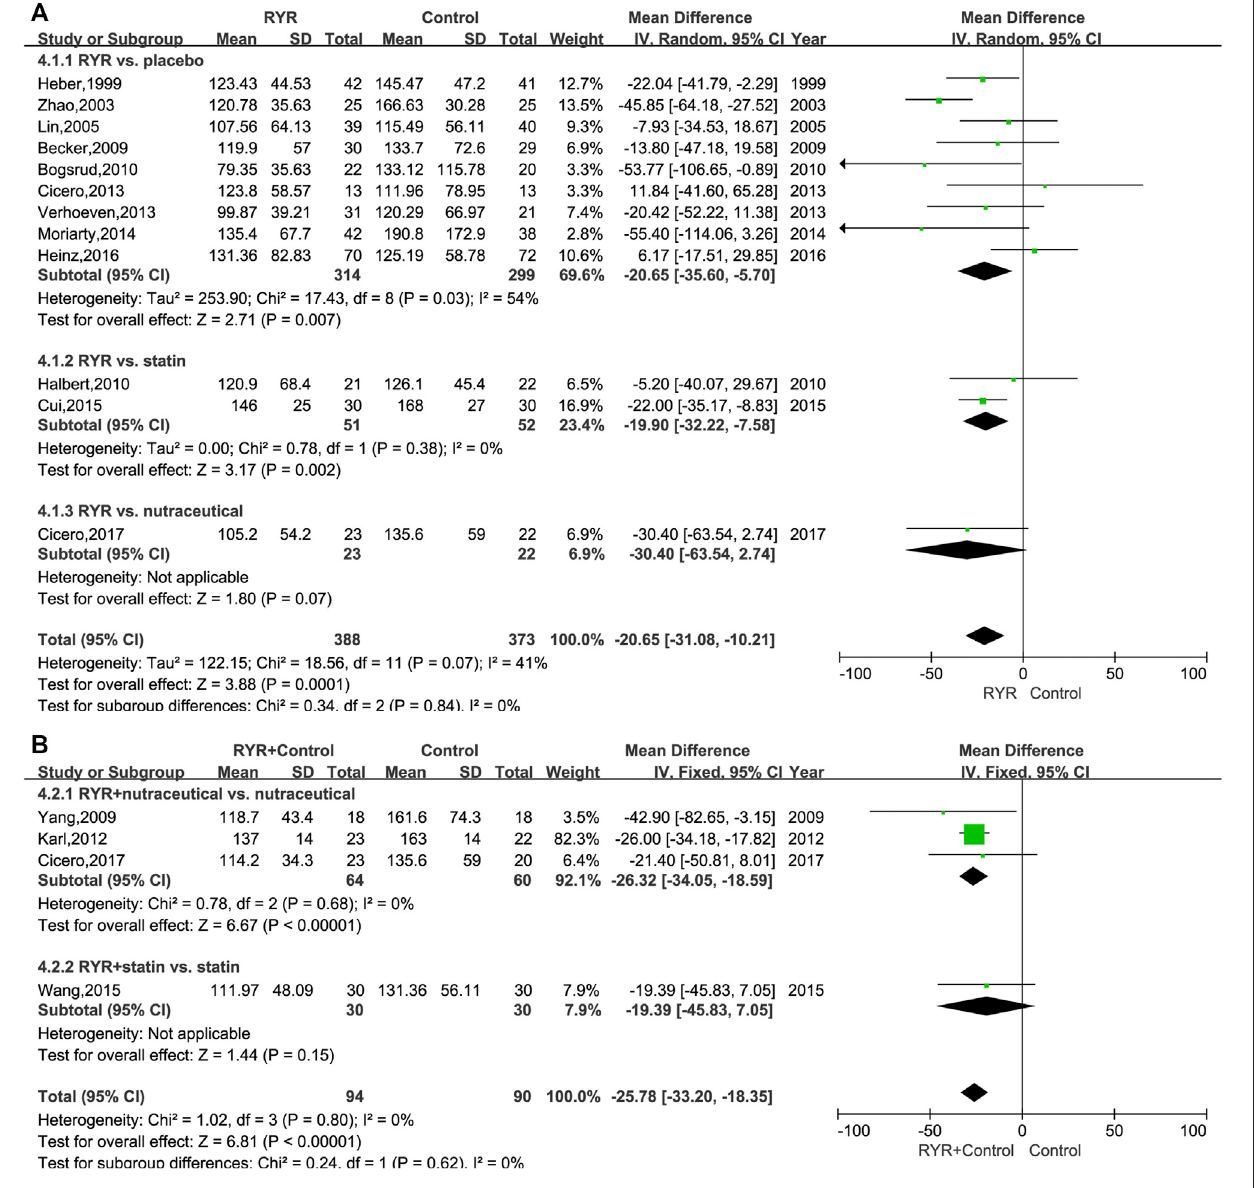
Frontiers in Pharmacology |